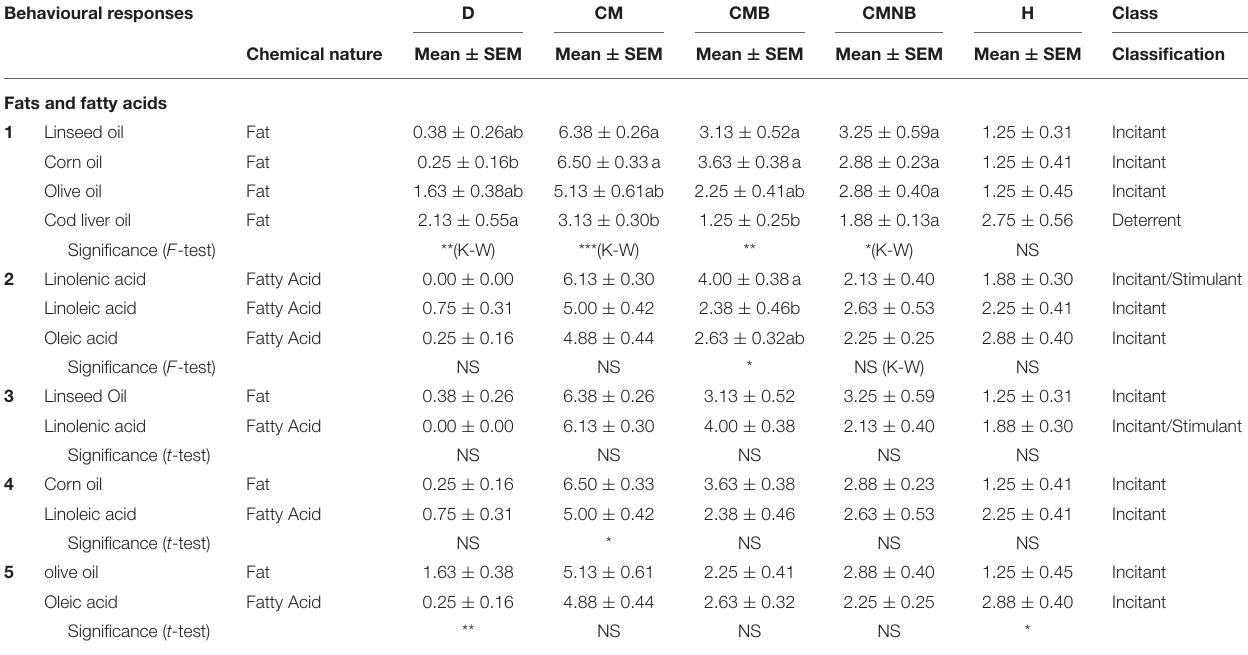
TABLE 6.2 | Comparisons of selected chemical stimuli by constituents or derivatives—lipids. Behavioural